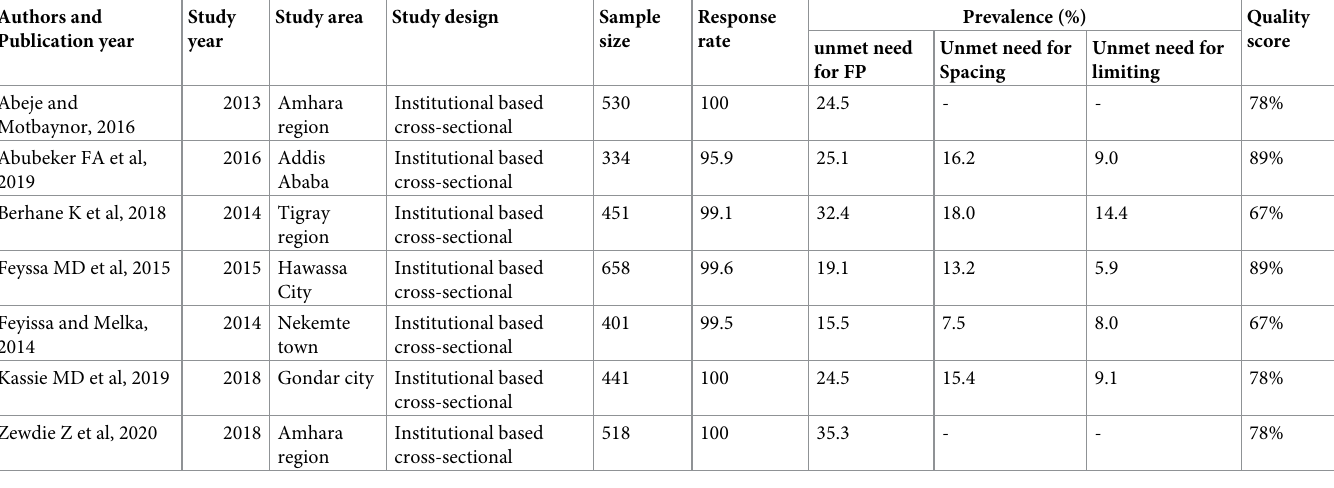
Table 2. Summary characteristics of studies included in the meta-analysis of the prevalence of unmet need among HIV positive women in Ethiopia.